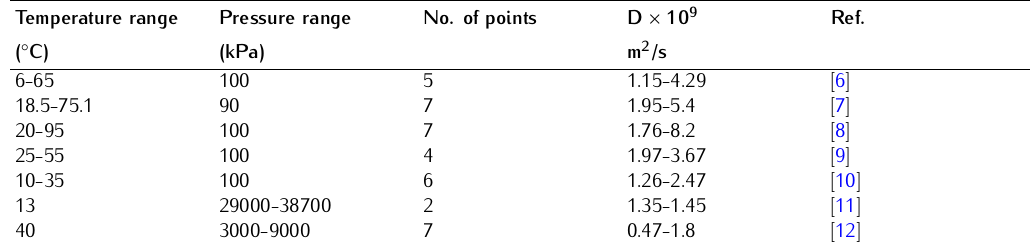
2 diffusivity into pure water.